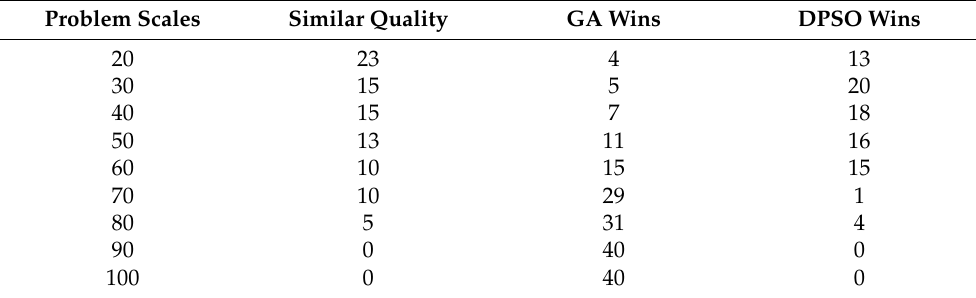
Table 3. Average traveled distance under the GA and DPSO algorithm. Problem Scales